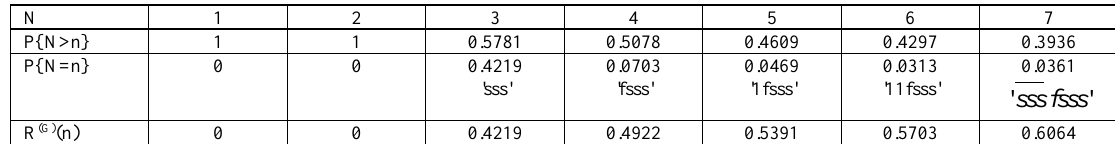
Table 1. R (G) (n) for n 1 =3, k cs =3, p 1 =0.75, p 2